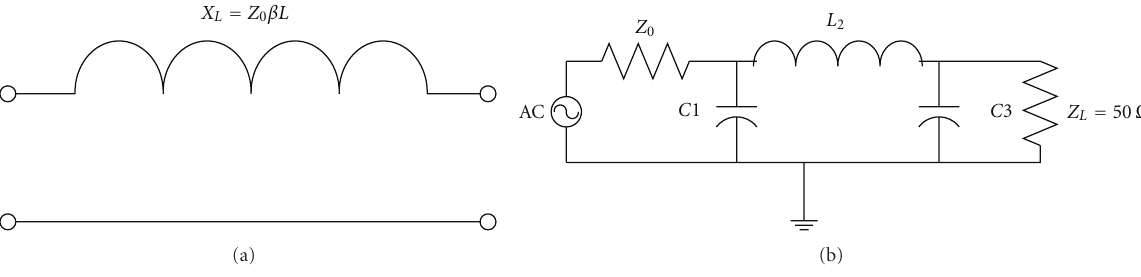
Figure 2: (a) Equivalent circuit for short length and high characteristic impedance transmission line and (b) third order low-pass filter